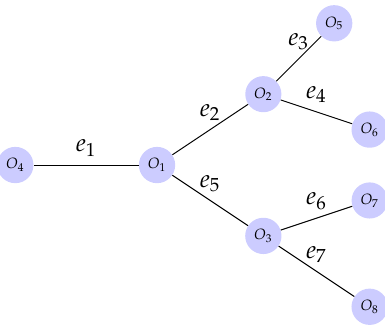
Figure 1. Graph of the tube